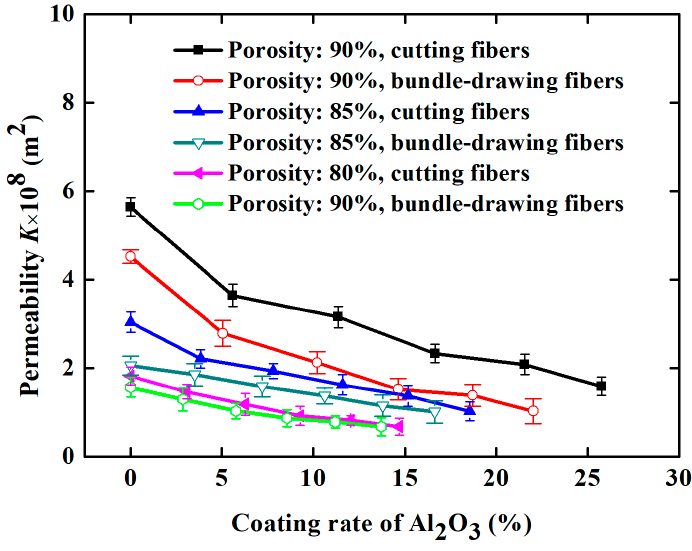
Figure 14. Permeability of samples with different Al 2 O 3 coating rates.